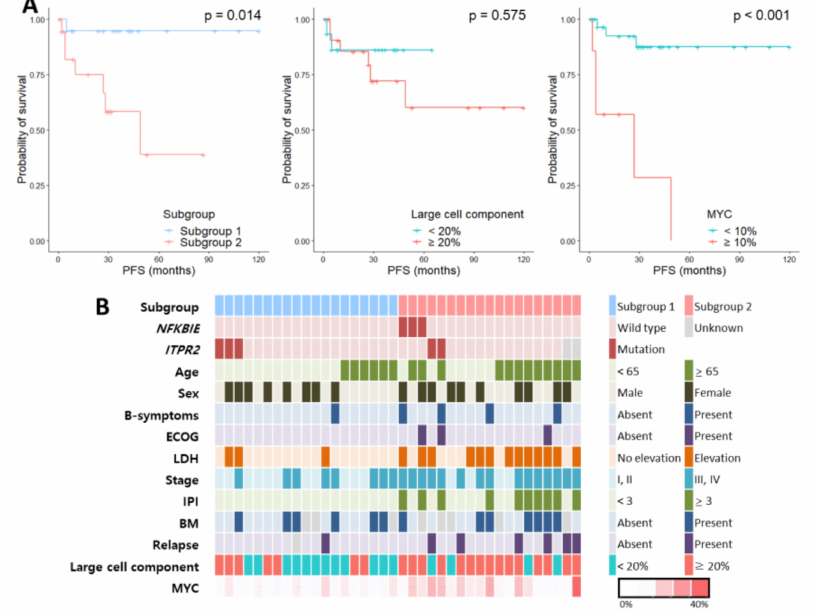
Figure 6. Summary of the clinicopathological characteristics. ( A ) Kaplan–Meier curves of progression-free survival (PFS) according to subgroups, large cell component, and MYC expression are shown. ( B ) The characteristics of the 38 NMZLs are summarized and